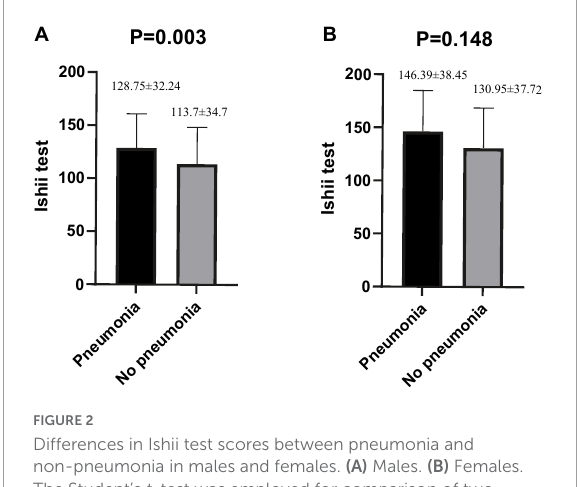
FIGURE2 Differences in Ishii test scores between pneumonia and non-pneumonia in males and females. (A) Males. (B) Females. The Student’s t -test was employed for comparison of two